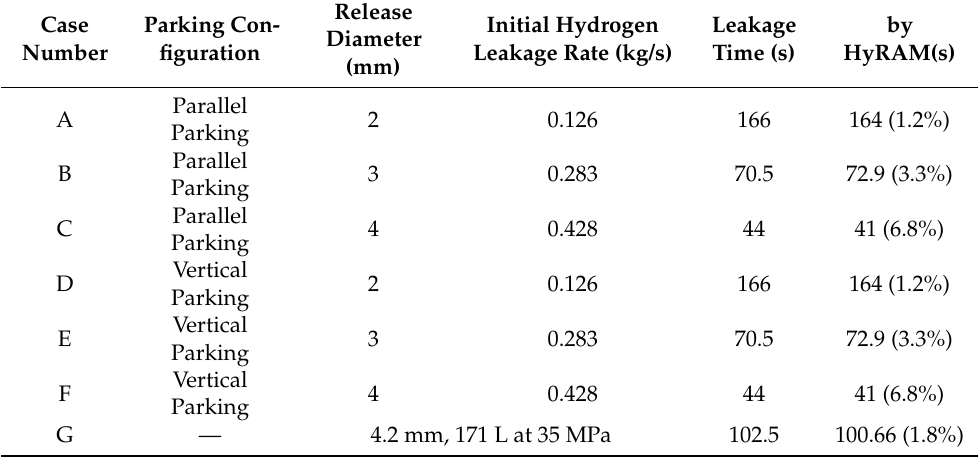
Table 2. Scenarios considered varying release diameter and parking configurations for unignited hydrogen